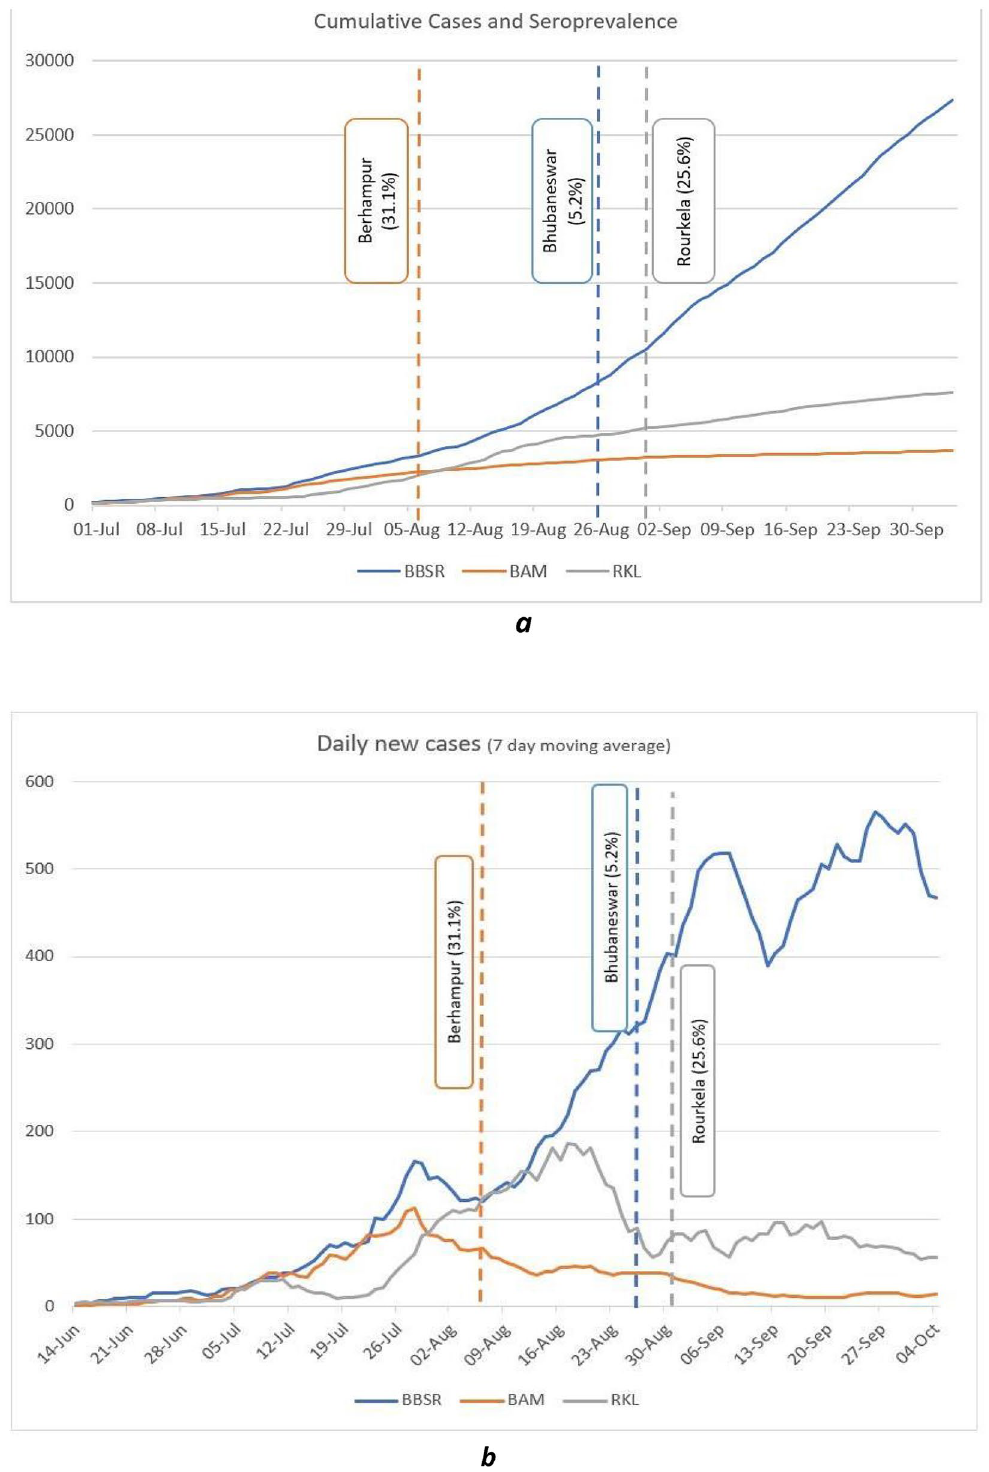
Figure 3. ( a ) 7 days moving average of new cases detected in three cities and point of seroprevalence. ( b ) Cumulative cases detected in the three cities and point of seroprevalence